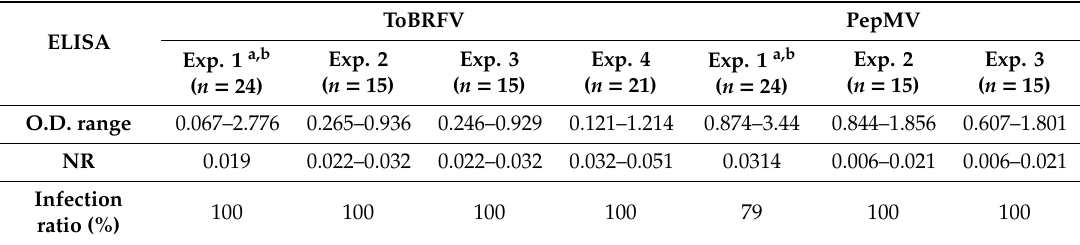
Table 1. Enzyme linked immunosorbent assay (ELISA) optical density (O.D.) results of pepino mosaic virus (PepMV) and / or tomato brown rugose fruit virus (ToBRFV) coat protein levels in symptomatic fruits subjected to inoculation